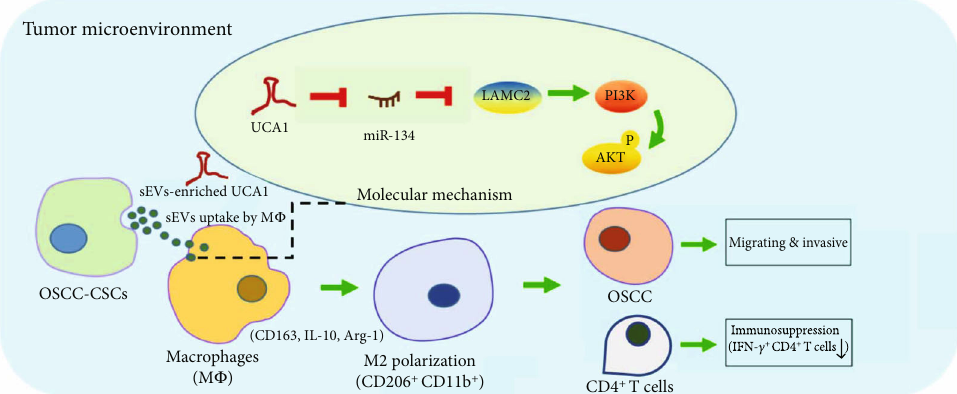
Figure 6: Schematic overview of the mechanism. OSCC-CSC-derived small extracellular vesicles (sEVs) transfer lncRNA UCA1, thus promoting M2 macrophage polarization via a LAMC2-mediated PI3K/AKT axis and further enabling cell migration and invasion of OSCC and modulating immunosuppression, partly by inhibiting CD4 + T-cell proliferation and IFN- γ